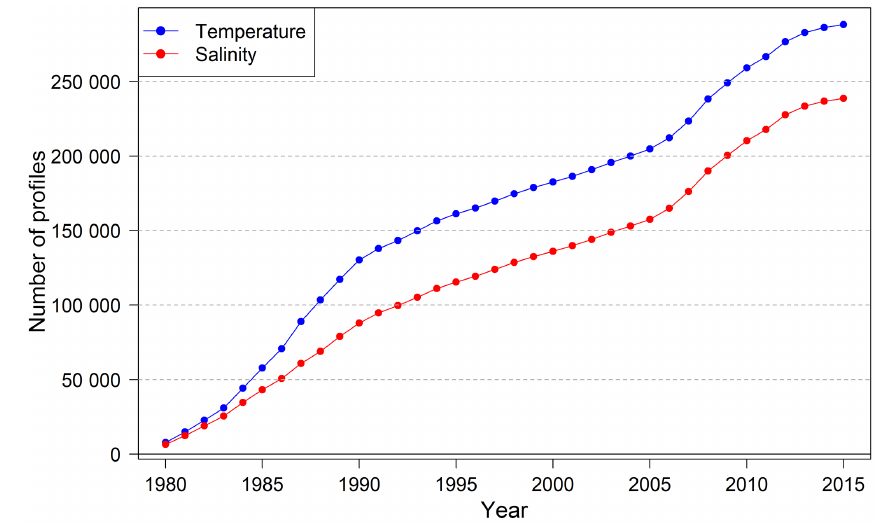
Figure 10. Evolution of the number of temperature and salinity profiles (cumulated) over the entire